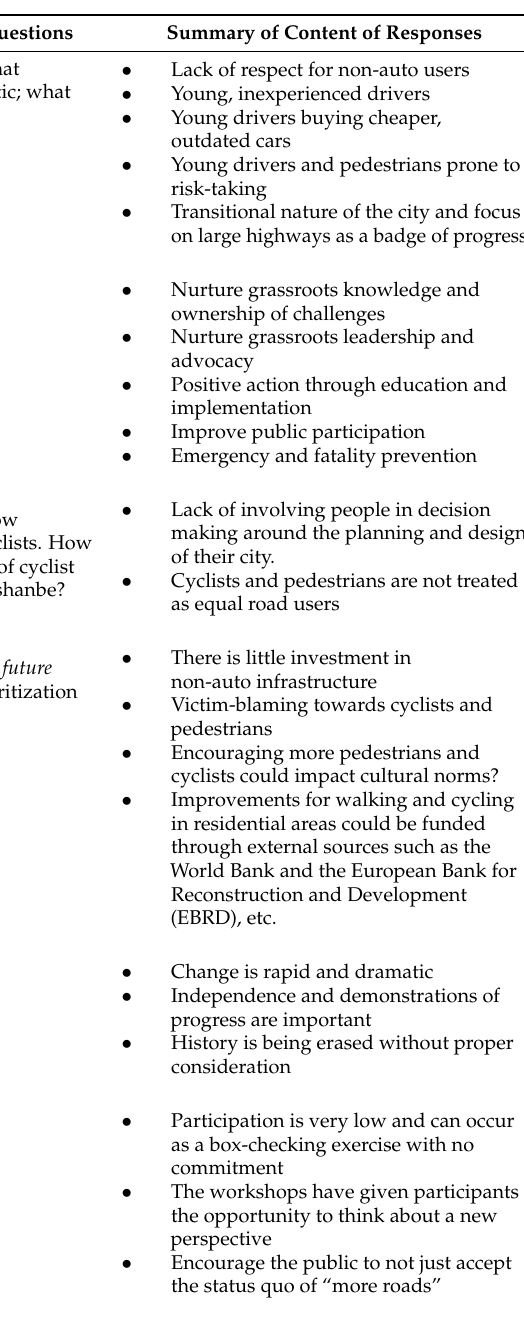
Table 4. Semi-structured interview questions and